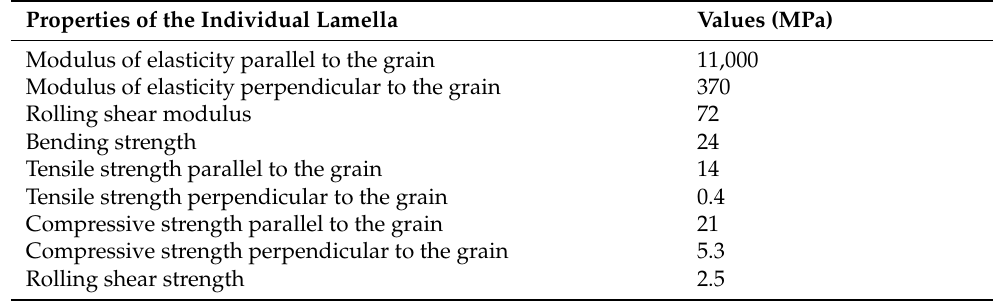
Table 2. Mechanical properties of the lamellas as supplied by the